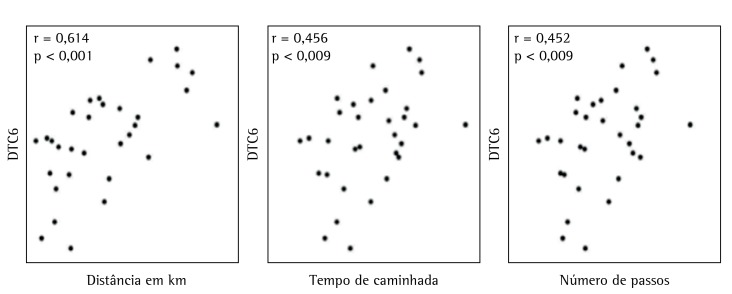
Correlação da distância percorrida no teste de caminhada de seis minutos
(DTC6) com a distância percorrida, tempo de caminhada e número de passos
mensurados pelo acelerômetro.